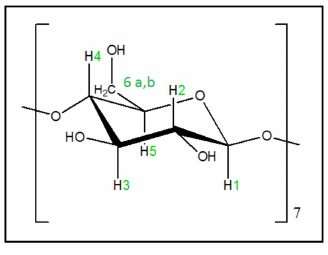
Figure 6. The glucose monomer in β